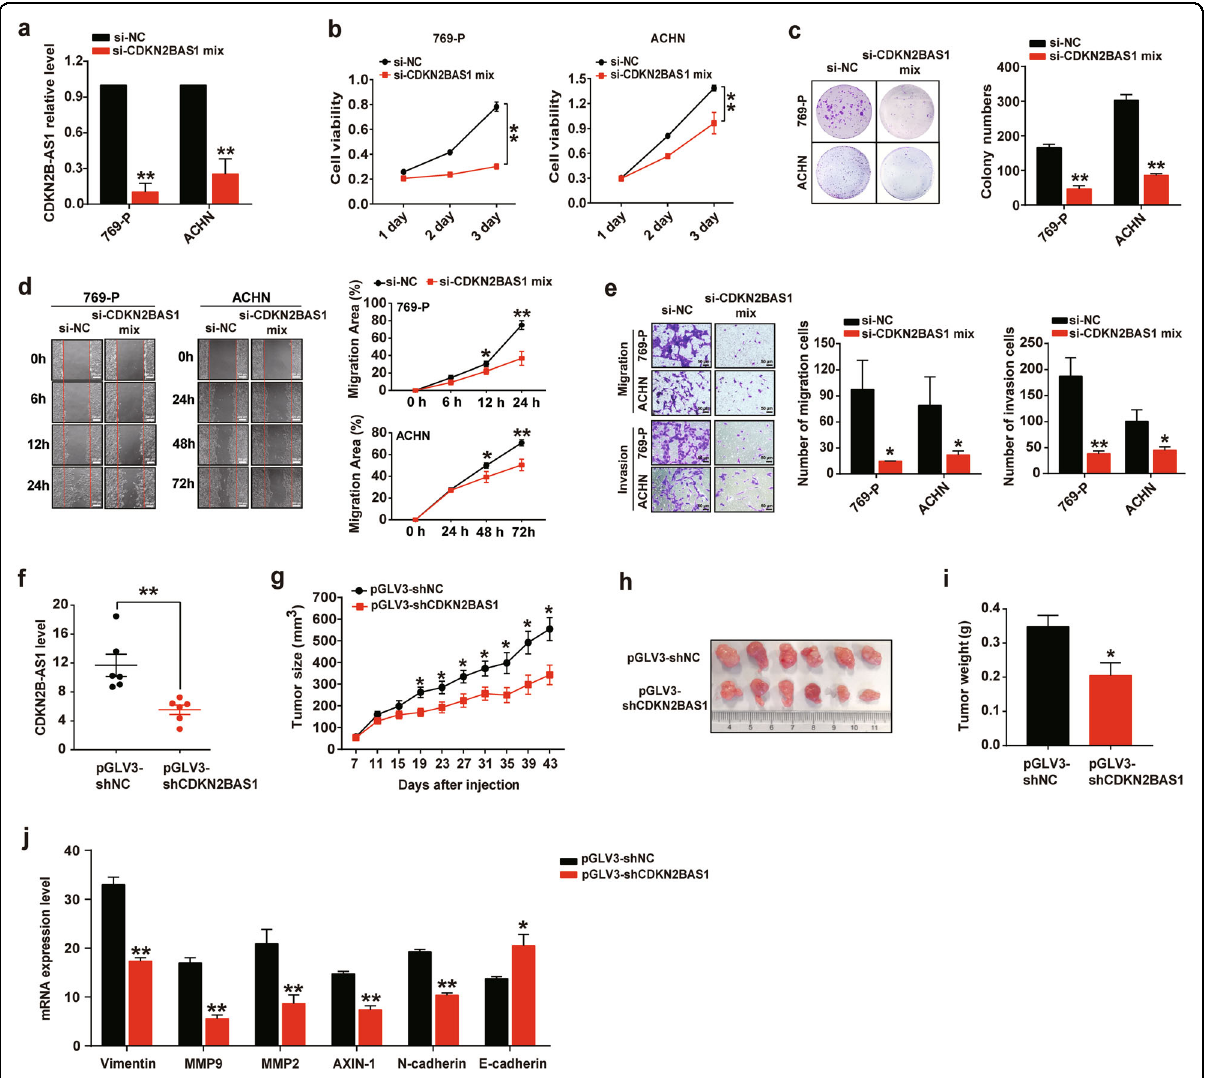
Fig. 2 Depletion of CDKN2B-AS1 suppresses KIRC growth and metastasis in vitro and in vivo. a qRT-PCR analysis of CDKN2B-AS1 expression in 769-P and ACHN cells transfected with siRNAs and ASOs against CDKN2B-AS1 (si-CDKN2B-AS1 mix) for 48 h, β -actin was used as the internal control. b , c Cell Counting Kit ‑ 8 (CCK-8) and colony formation assays were used to determine cell viability and proliferation in 769-P and ACHN cells transfected with the si-CDKN2B-AS1 mix or si ‑ negative control (NC). d , e Wound healing and transwell assays were performed to assess the cell migration and invasion, ImageJ software was used for migration area calculation and cell counting. Scale bar: 200 μ m ( d ) or 50 μ m ( e ). f – j ACHN cells pre-infected with lentiviral were subcutaneously injected into the fl ank of each BALB/c nude mouse ( n = 6 per group). qRT-PCR analysis of CDKN2B- AS1, vimentin, MMP9, MMP2, AXIN-1, N-cadherin, and E-cadherin expression in tumor tissues, β -actin was used as the internal control ( f , j ); growth curves of tumors in the nude mice ( g ); tumor photographs ( h ); and tumor weight ( i ). Error bars represent the SEM. ** p < 0.01 vs. si-NC or pGLV3-shNC, * p < 0.05 vs. si-NC or pGLV3-shNC. Data are representative from three independent experiments, p value calculated by independent sample t